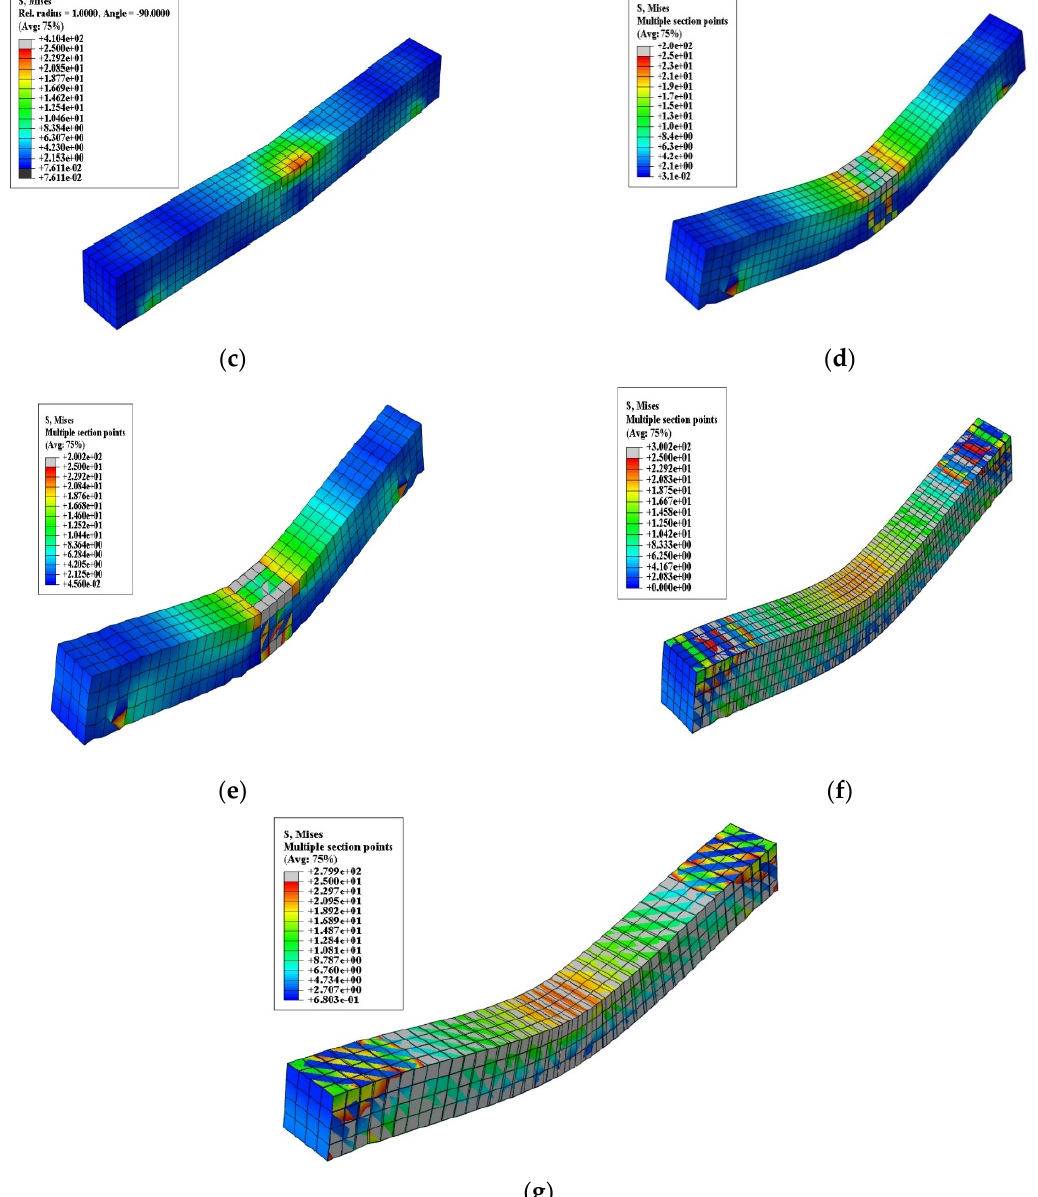
Figure 10. Stress Pattern- ( a ) Conventional Beam, ( b ) SFRC beam, ( c ) SFRC only at plastic hinge length of a beam, ( d ) Carbon fiber mesh jacketing at Plastic hinge length of a conventional beam, ( e ) SFRC and Carbon fiber mesh jacketing only at a plastic hinge length of a beam, ( f ) Carbon fiber mesh jacketing for a total length of a conventional beam, ( g ) Carbon fiber mesh jacketing for total length with SFRC at plastic hinge length.